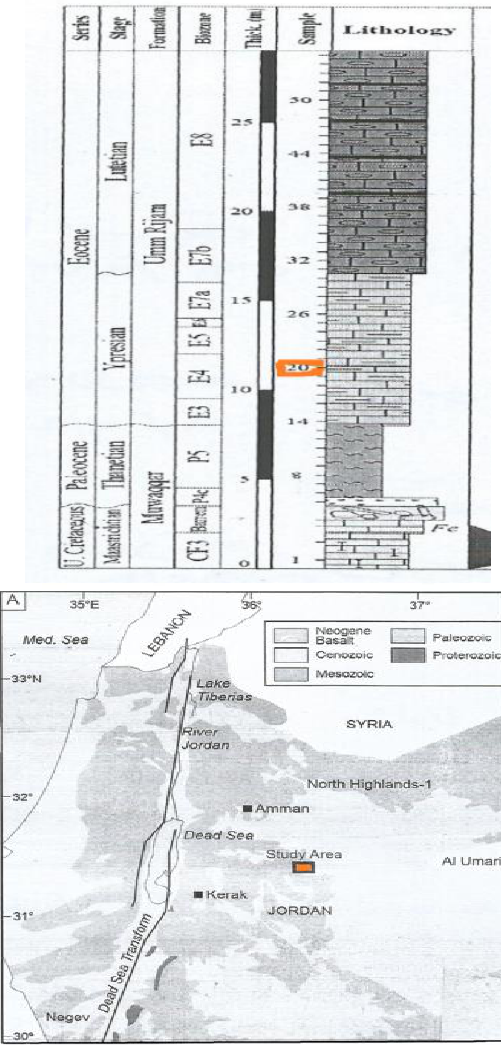
Figure 4: The stratigraphic section and location map of Ghuzayma section, central Jordan, (Alhejoj et al.,